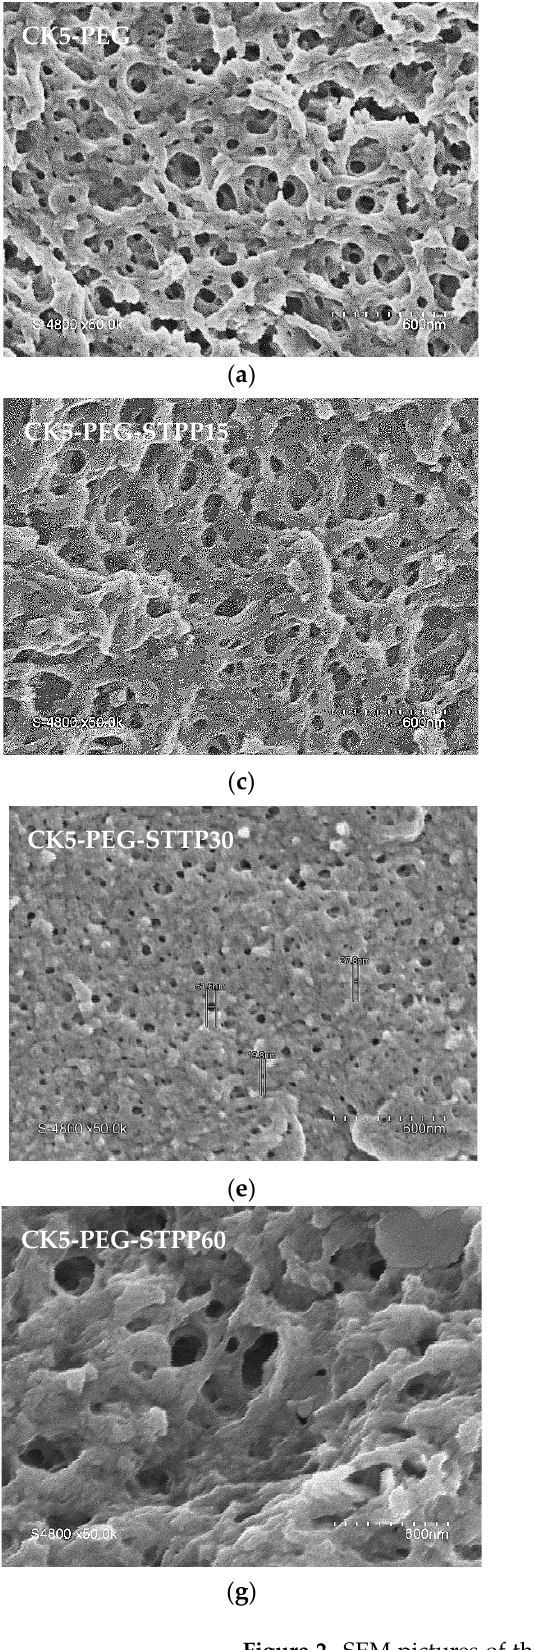
Figure 2. SEM pictures of the membrane surface after 0, 15, 30 and 60 min of reaction time with STPP ( a ), ( c ), ( e ), ( g ), respectively ( left , magnification × 50,000) and membrane cross-section ( right , magnification × 500 for ( b ), ( d ), ( f ) and × 300 for ( h